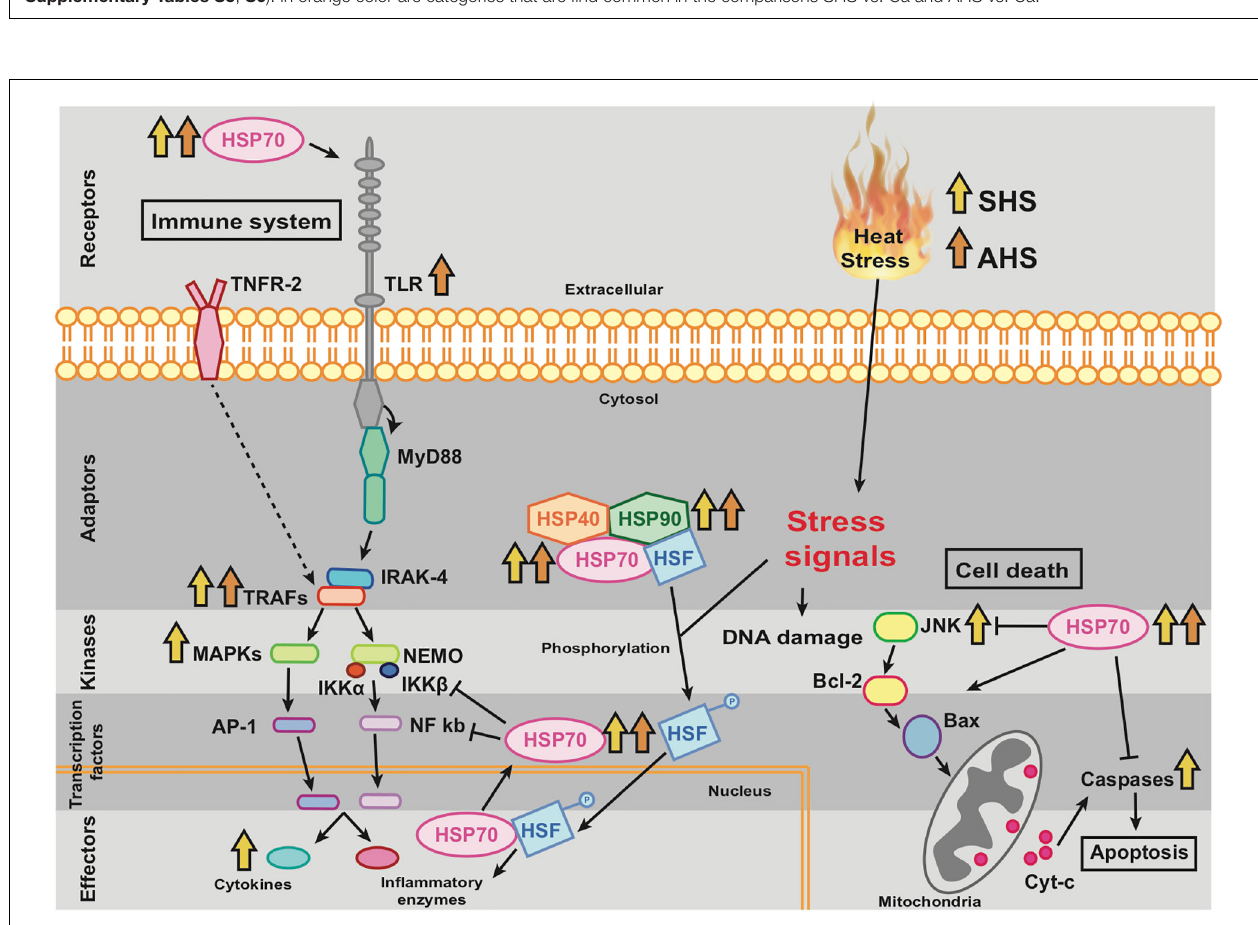
FIGURE 5 | Theoretical representation and interconnection of molecular pathways related to thermal stress which have been appeared partially in our experiment. The arrows indicate which of the genes, included in those pathways, were upregulated. The orange arrows refer to genes upregulated in SHS (Short-term Heat Stress) and red arrows to genes upregulated in AHS (Acute Heat